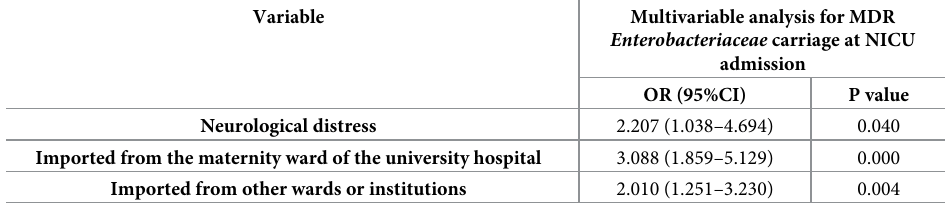
Table 3. Multivariable analysis for MDR- Enterobacteriaceae carriage at NICU admission and acquisition during